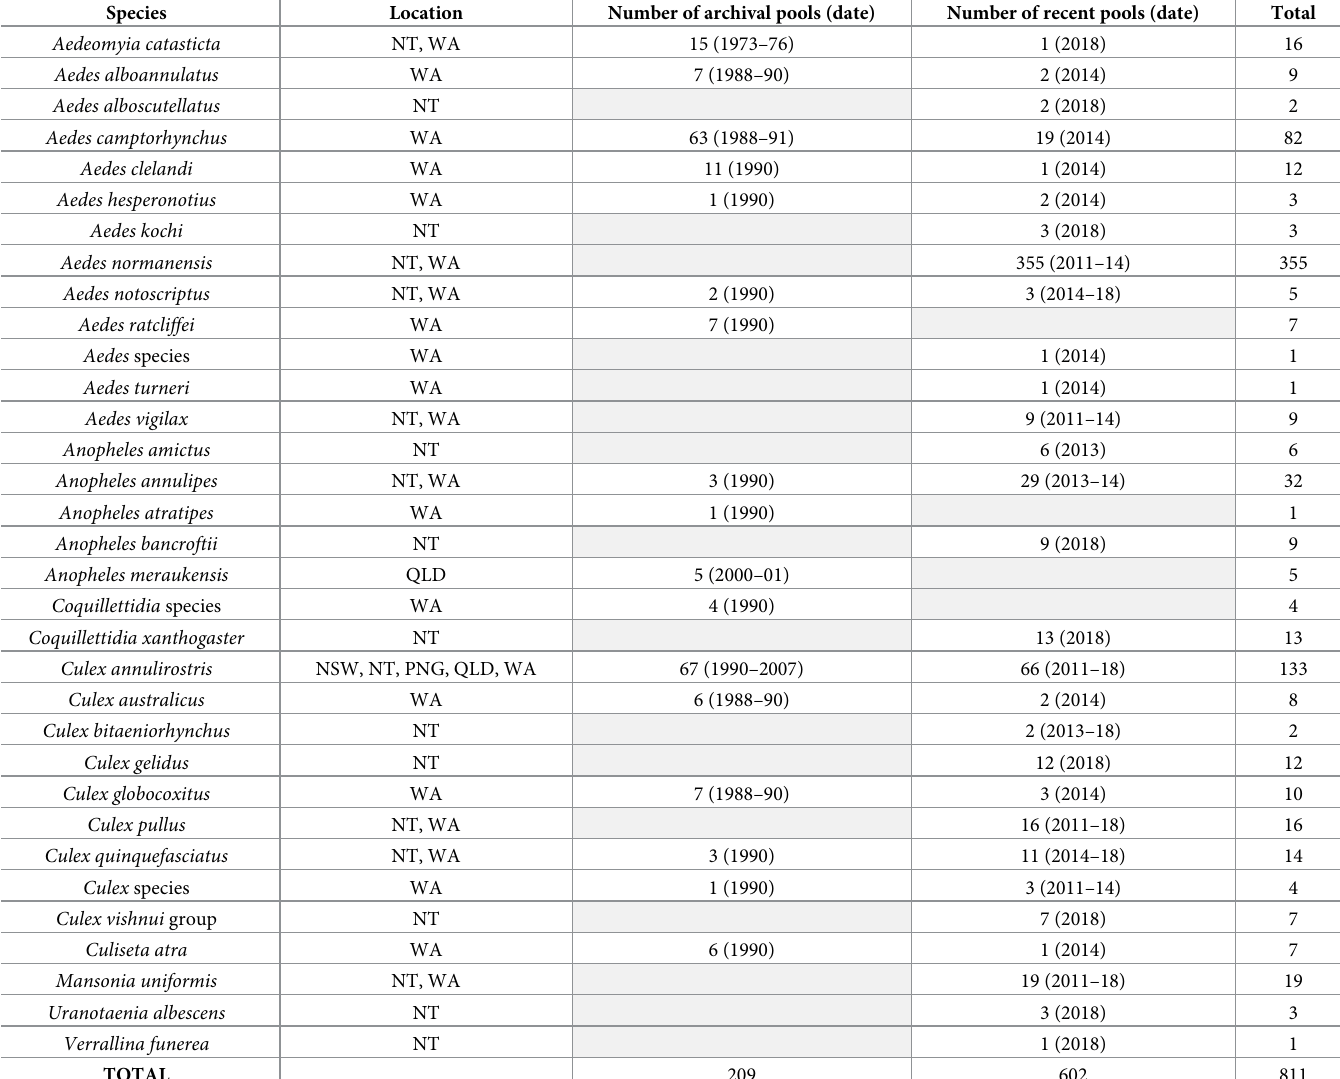
Table 1. Summary of mosquito pools screened for BgV in Australasia. (NT = Northern Territory, Australia; PNG = Papua New Guinea; QLD: Queensland, Australia; WA = Western